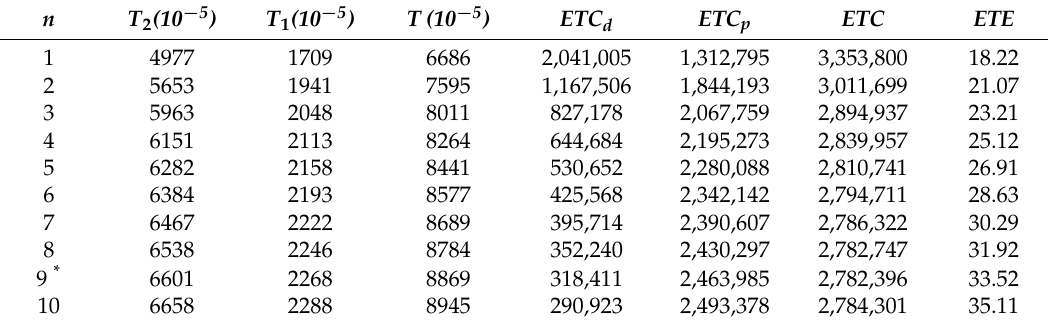
Table 4. Expected total cost for different n in Model 2.